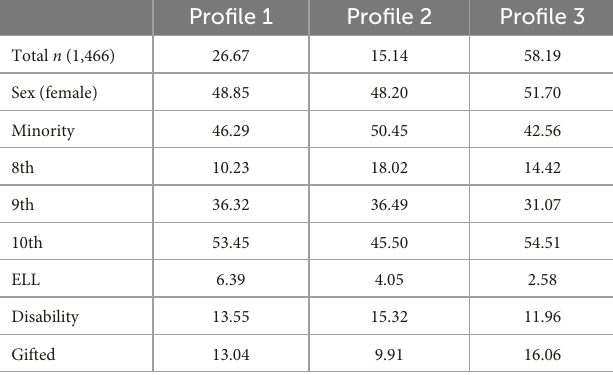
TABLE 7 Demographic % by